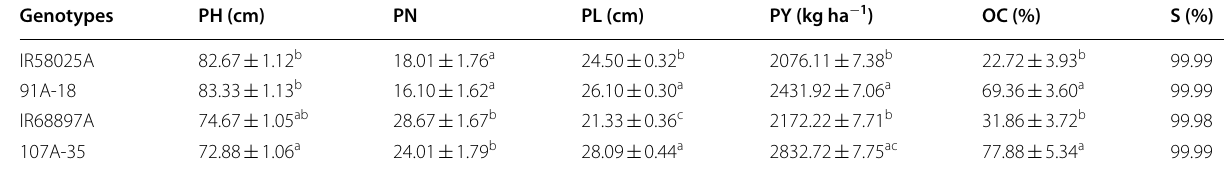
abc are LSD significant values at 0.05 level of